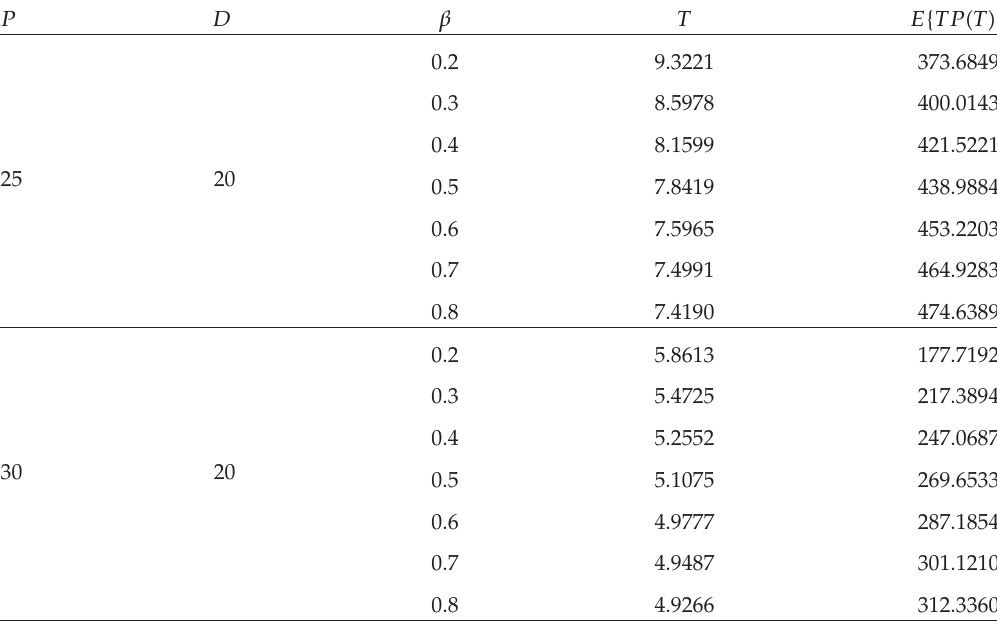
Table 3: Results due to di ff erent β